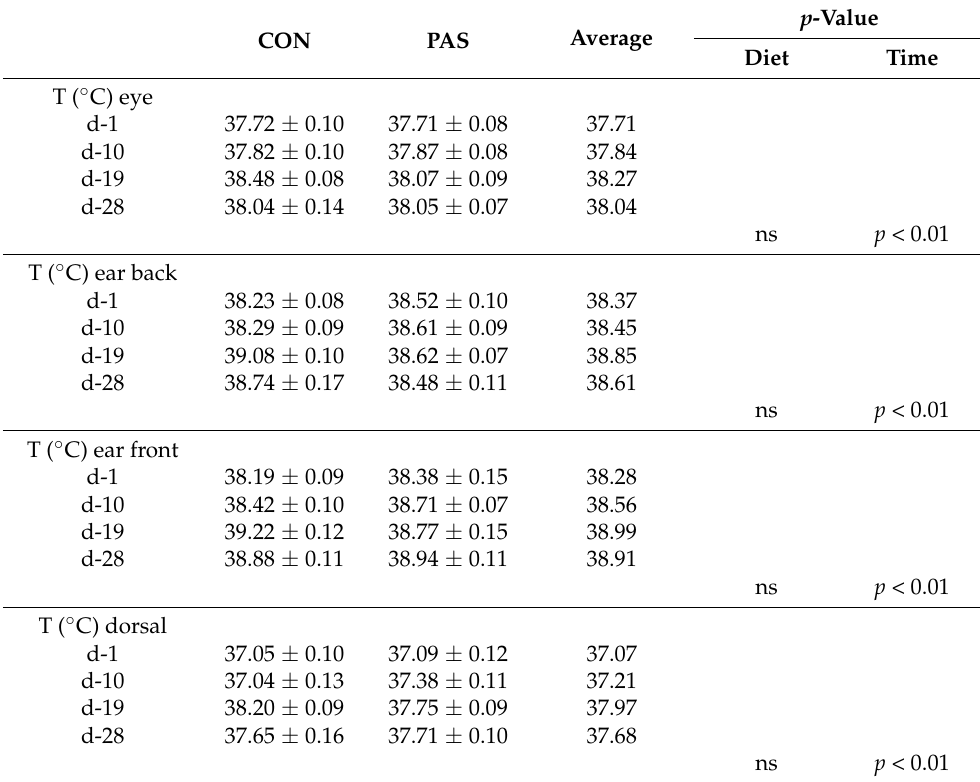
Table 3. Descriptive statistics of temperatures (mean ± SE) measured in the eye, ear (front and back position) and dorsal area in two experimental groups (CON and PAS). CON